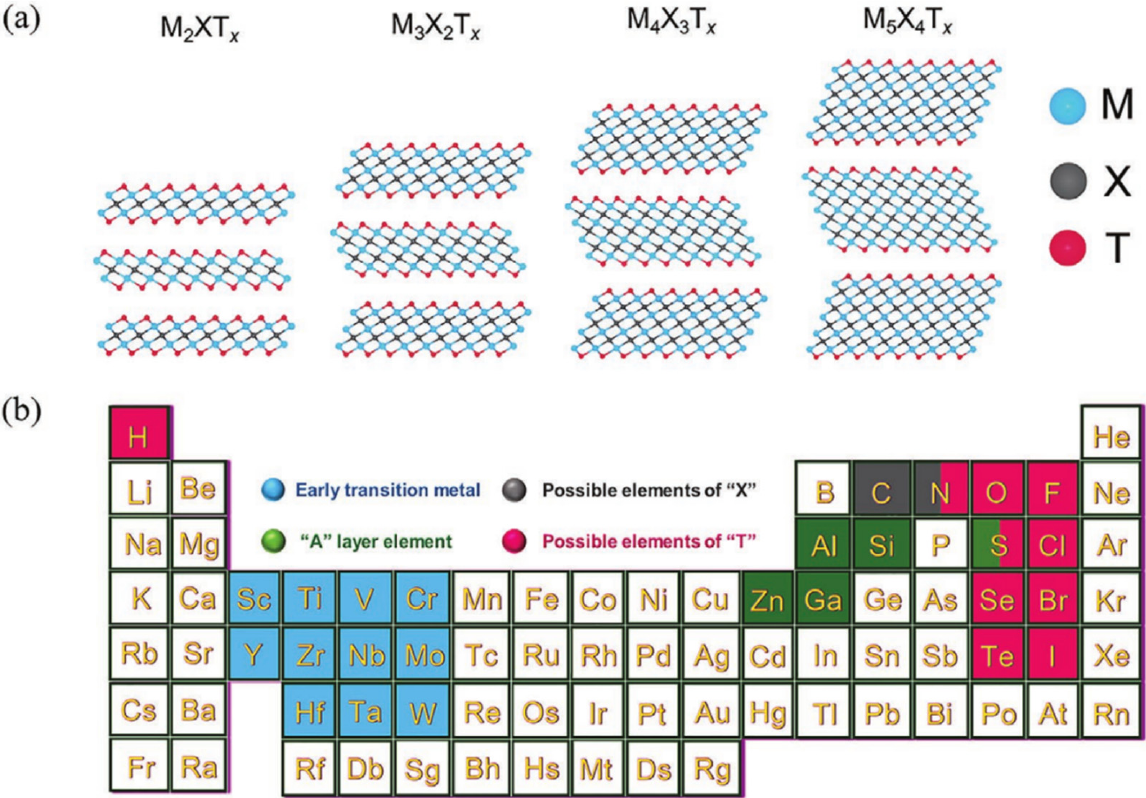
Figure 1. ( a ) Schematic structure of MXenes. ( b ) M, A, X, and T elements for MAX and MXene (Re-